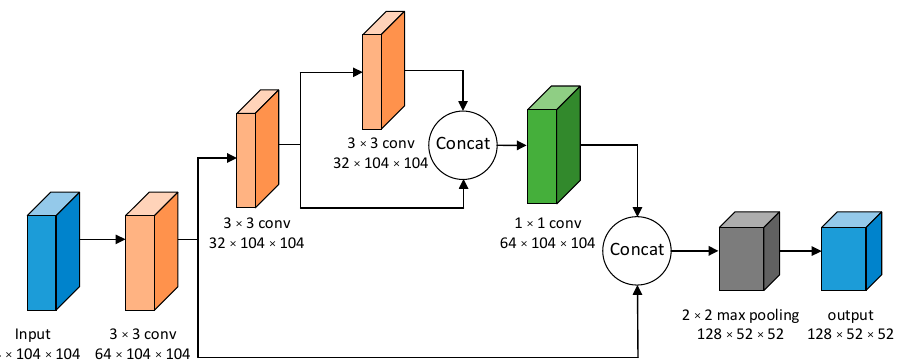
Figure 2. Resblock_body network